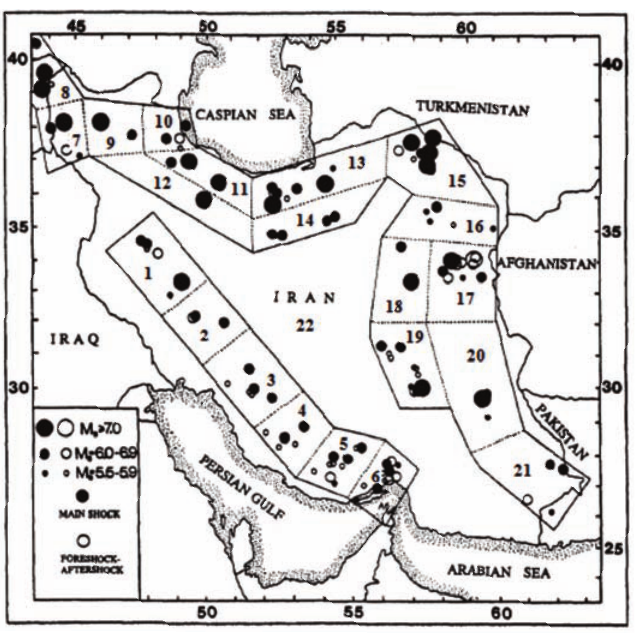
Figure 3. The siesmogenic source zones of Iran proposed by Sadeghian (present